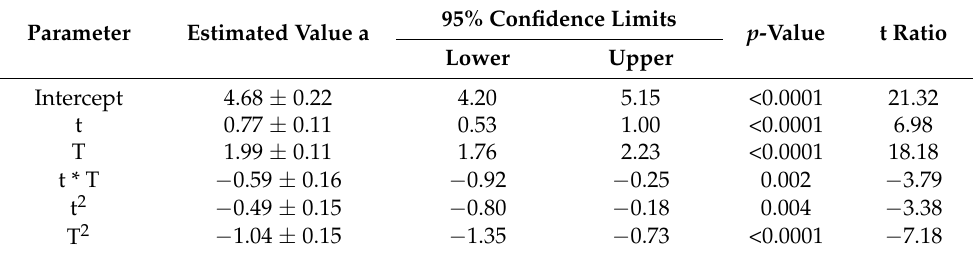
Table 3. Calculated values and fitting statistics for the parameters of the polynomial mathematical equation predicting the attached to SS coupons population (Log 10 CFU/cm 2 ) of the four-strain L. monocytogenes cocktail as a function of time (t) and temperature